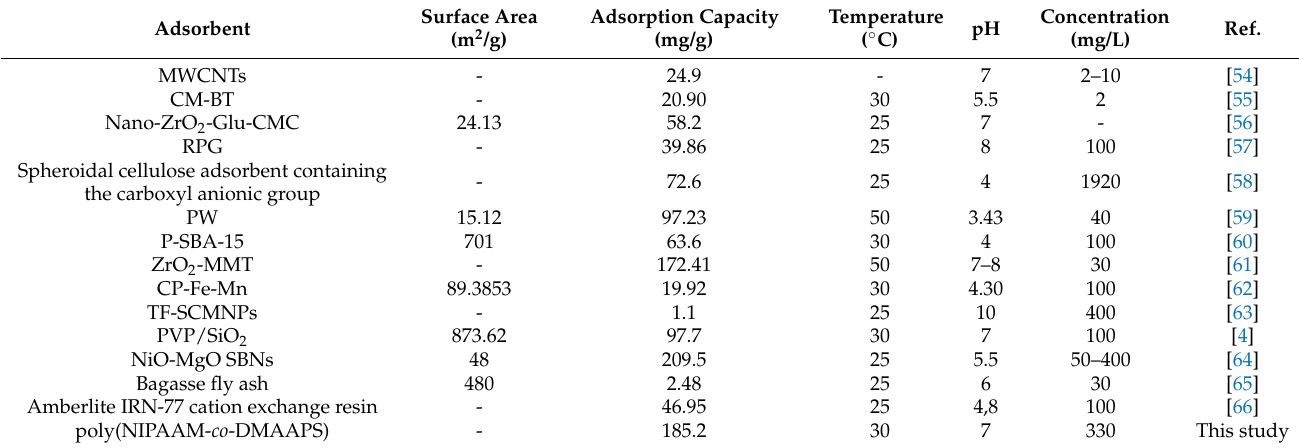
Table 2. Comparison of different adsorbents toward the Cr 3+ ions 1 .